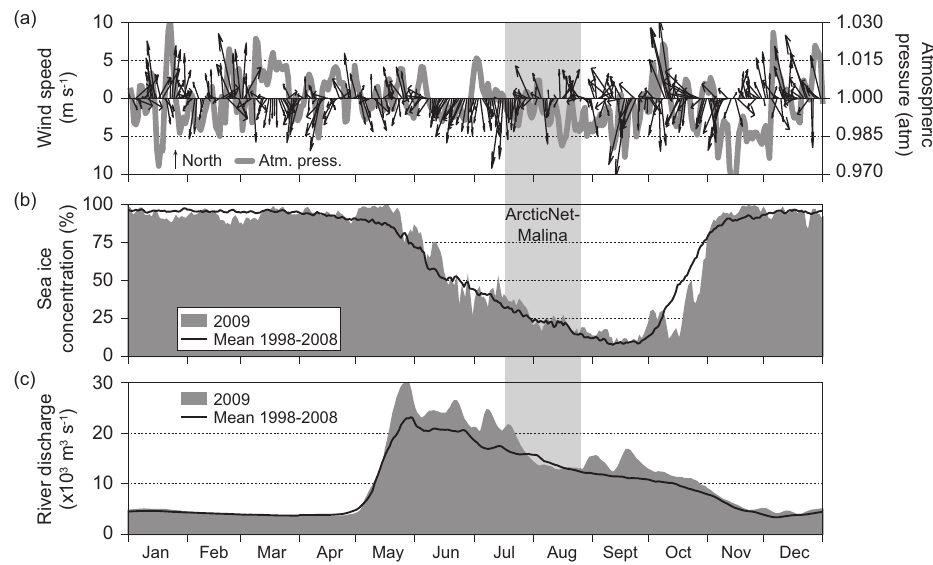
Fig. 2. Time series from January to December 2009 of (a) near-surface wind vectors and atmospheric pressure (source: NCEP); (b) daily ice concentration and recent decadal average (source: NSIDC); and (c) daily Mackenzie River discharge and decadal mean (as recorded at station Arctic Red River). Data from panels a–b correspond to regional averages over the entire southeast Beaufort Sea as defined as the area shown in Fig. 1. The gray-shaded column indicates the temporal window within which the ArcticNet-Malina campaign was